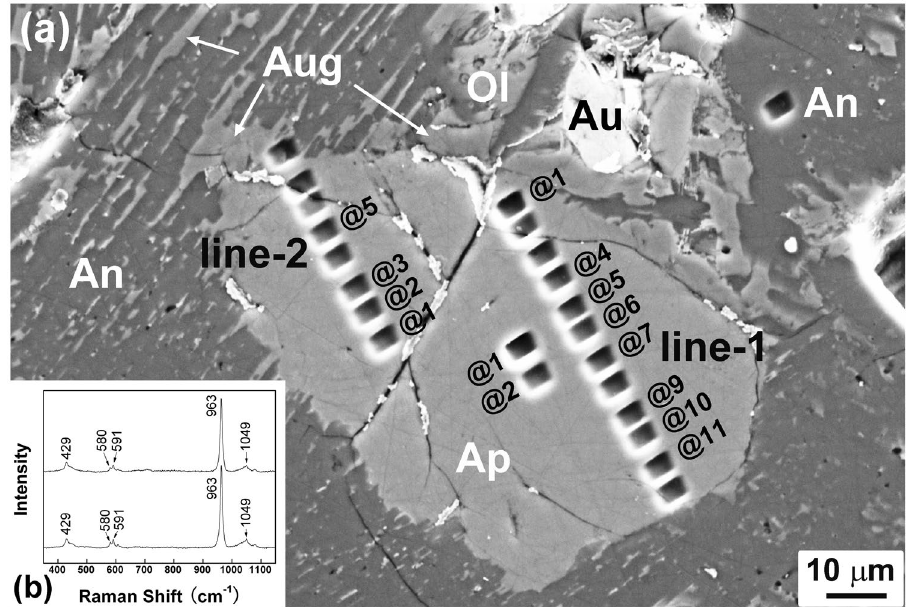
Figure 1. Petrographic and mineralogic characterization of the apatite grain in the feldspathic breccia Dhofar 458. ( a ) Back-scattered electron (BSE) image of the apatite grain, showing that it was subhedral and partially corroded by recrystallized anorthite-augite intergrowths. The rectangular pits are from NanoSIMS analyses. The spot numbers are labelled beside the pits. ( b ) Raman spectra of the apatite grain, exhibiting characteristic bands of F,Cl-apatite at 963, 429, 580, 591, and 1050 cm − 1 . Abbreviations: Ap, apatite; An, anorthite; Aug, augite; Ol,